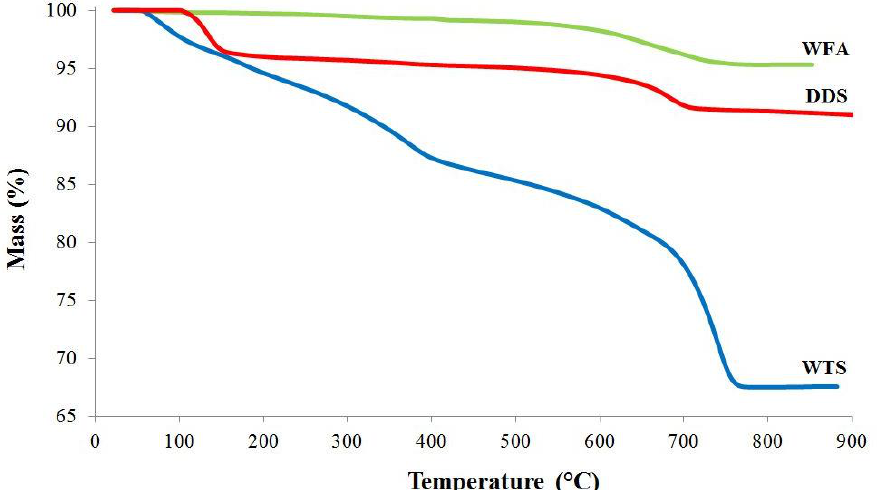
Figure 5. Thermal analysis results for the three coal combustion